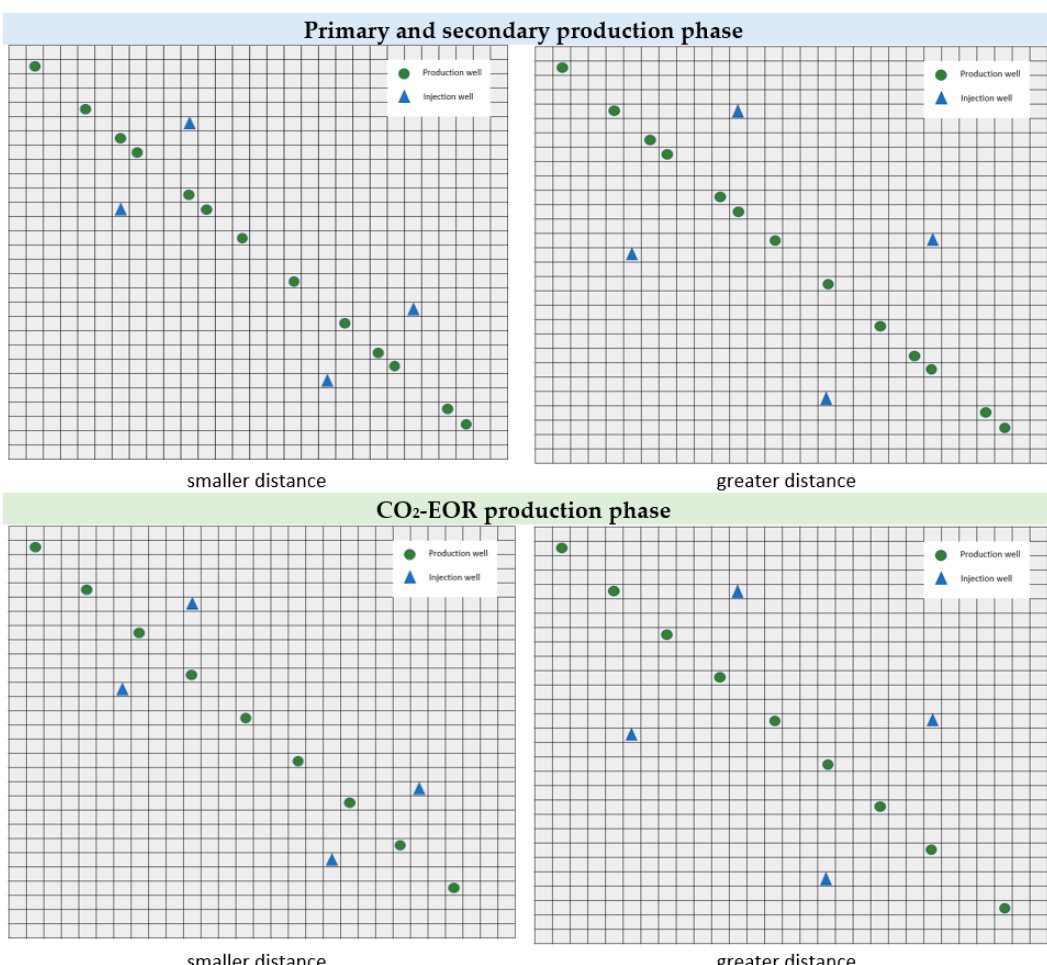
Figure 1. Models grid scheme. CO 2 -EOR: CO 2 -enhanced oil recovery.